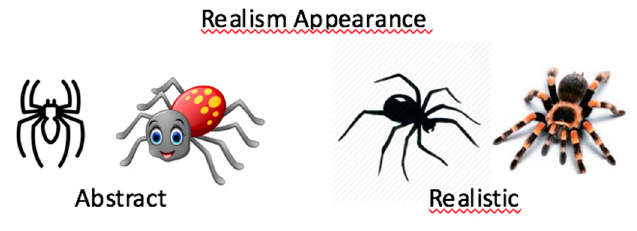
Figure 5. Example of abstract and realistic images for a